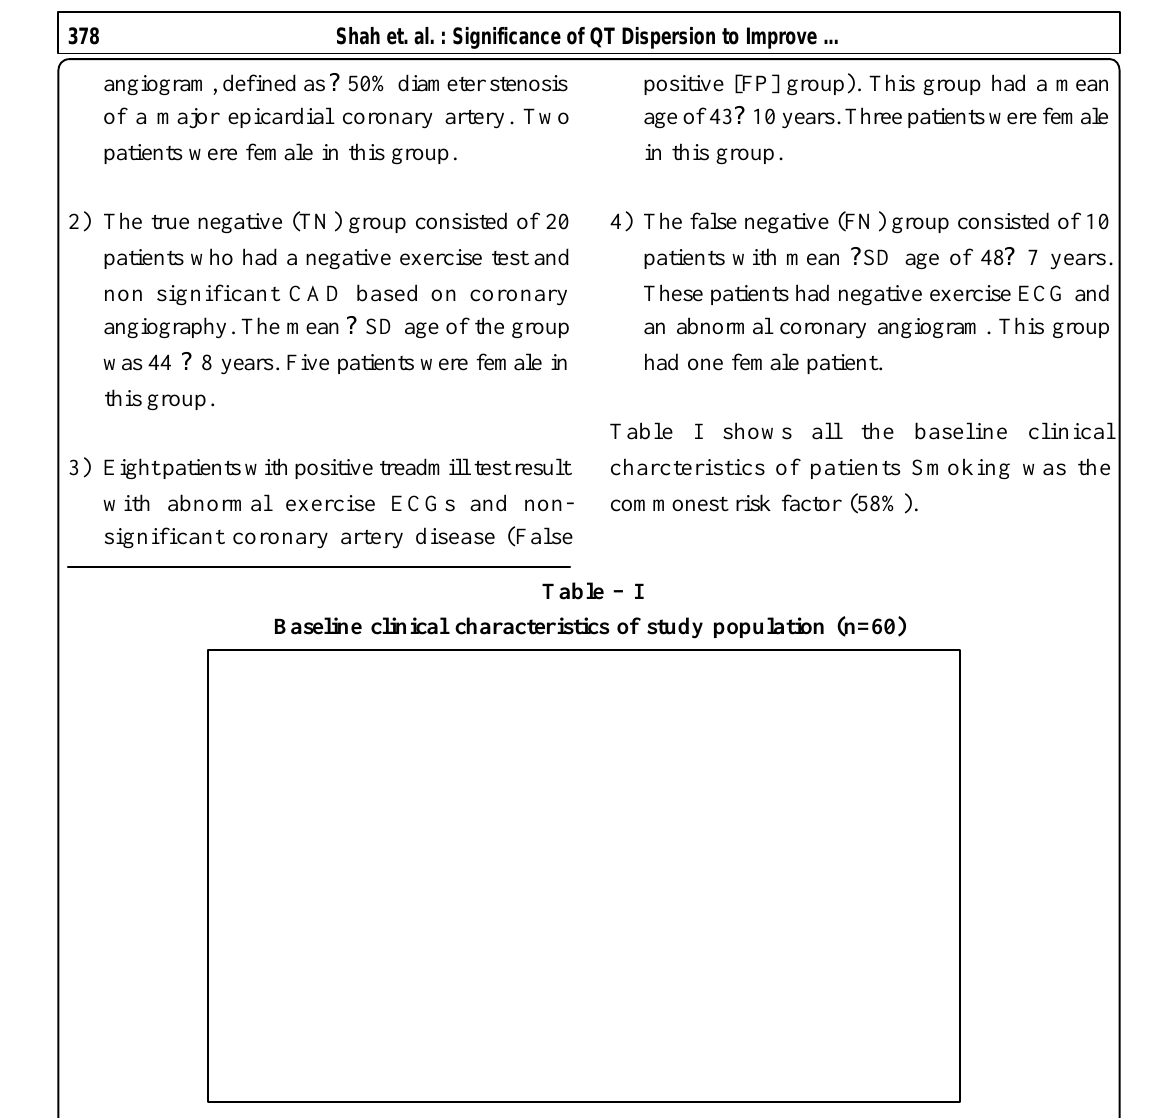
Resting electrocardiographic